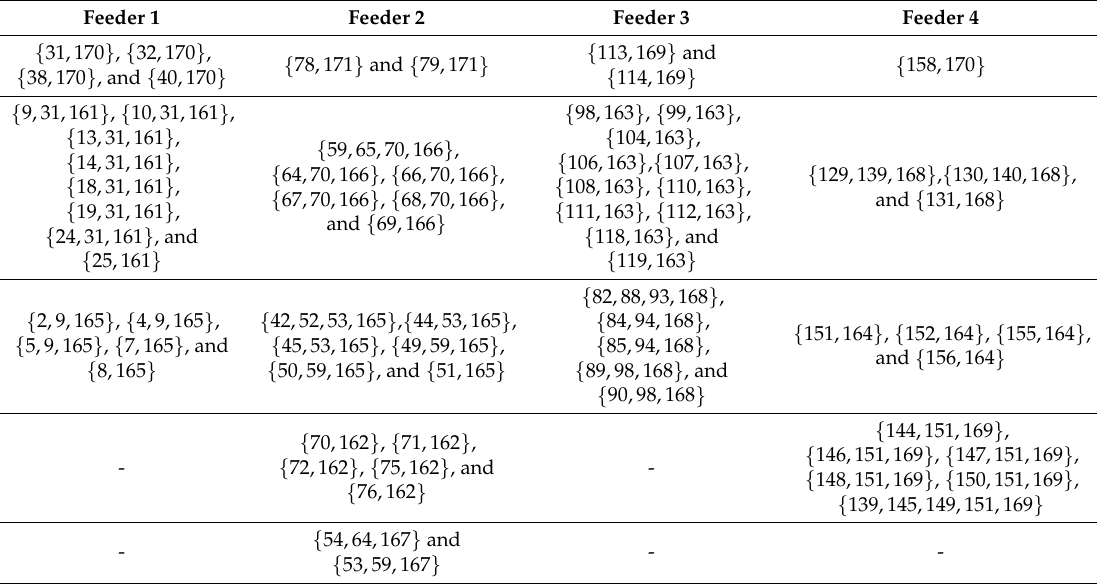
Table 1. The elite genes (EG) of the case study.